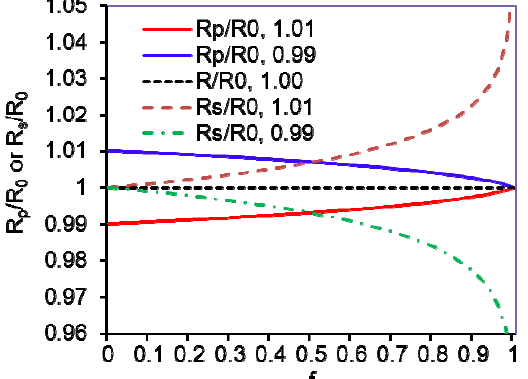
Figure 4. Simulated isotope ratios in product ( R ) in the substrate ( R isotope ratio ( R 0 (V/K) = 1.01 and